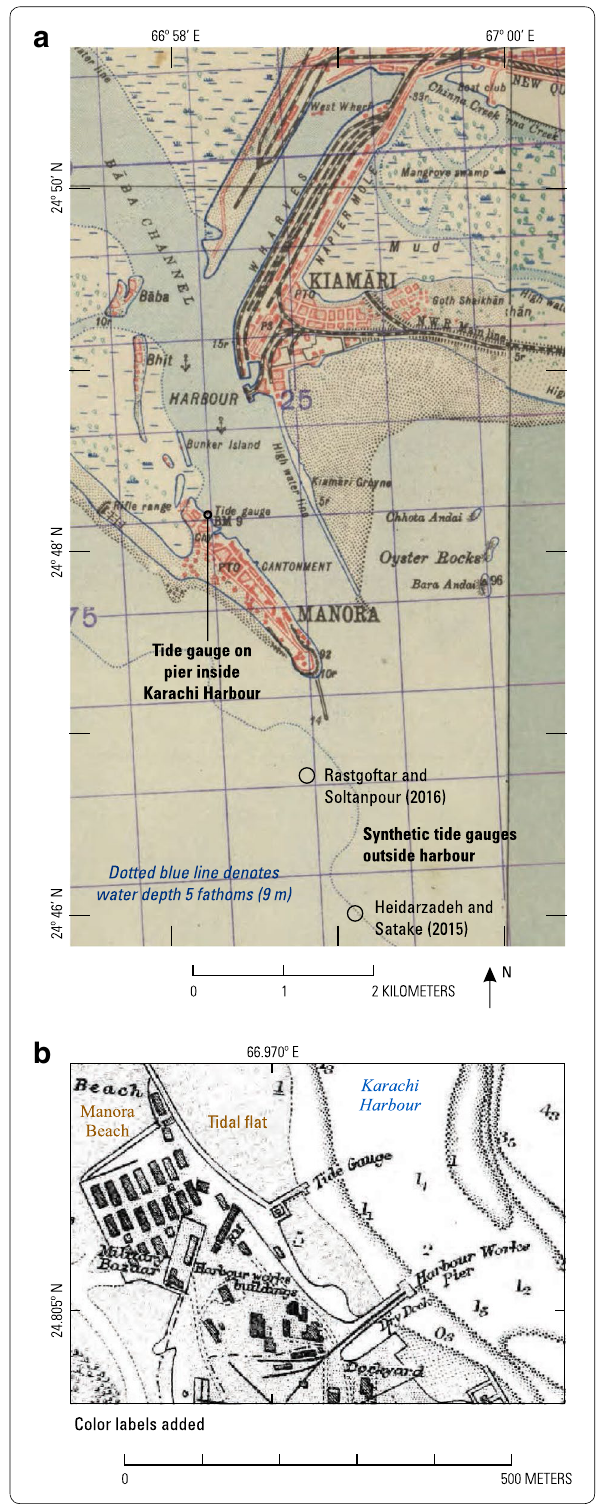
Fig. 2 Location of tidal observatory, on pier at 24.804°N, 66.970°E. a Karachi Harbour and vicinity, showing locations of synthetic tide gauges used in tsunami modeling: 24.767°N, 66.985°E (Heidarzadeh and Satake 2015, p 626); and 24.78°N, 66.98°E (Rastgoftar and Soltanpour 2016, p 942). An addition synthetic gauge, at 24.46°N, 66.80°E (Rajendran et al. 2008, p 1742), is outside the map area 40 km southeast of the pier. Base map from Survey of India One-Inch Sheets 35 L/13, 3rd ed., 1945, and 35 P/1, 4th ed., 1944, both originally surveyed 1925–1926. Military grid in purple. b Detail from